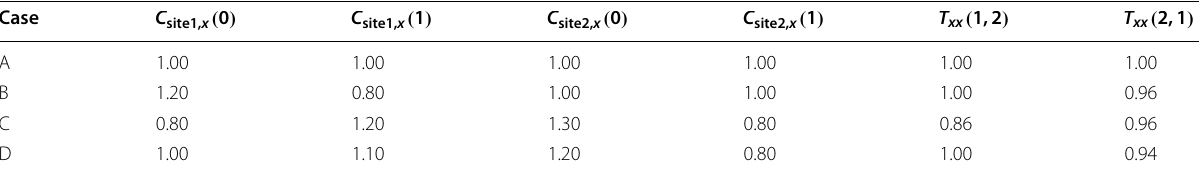
Table 3 Summation of C site1, x ( 0 ) , C site1, x ( 1 ) , C site2, x ( 0 ) , and C site2, x ( 1 ) , and the resultant values of T xx ( 1,2 ) and T xx ( 2,1 )